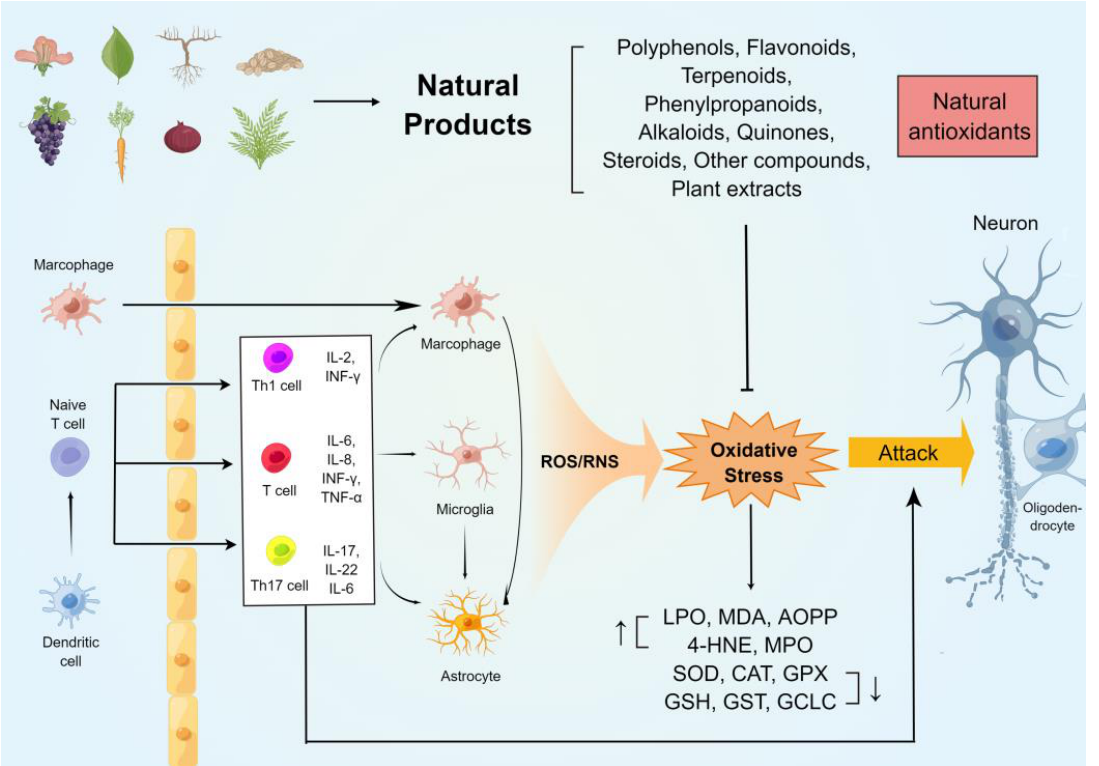
Figure 1. The neuroprotective effects of natural products in animal models of MS. Natural products alleviated ROS/RNS overgeneration, lipid peroxidation, oligodendrocytes loss, and neuronal injury; increased antioxidant enzymes, lipid metabolism, and myelin repair, among others.